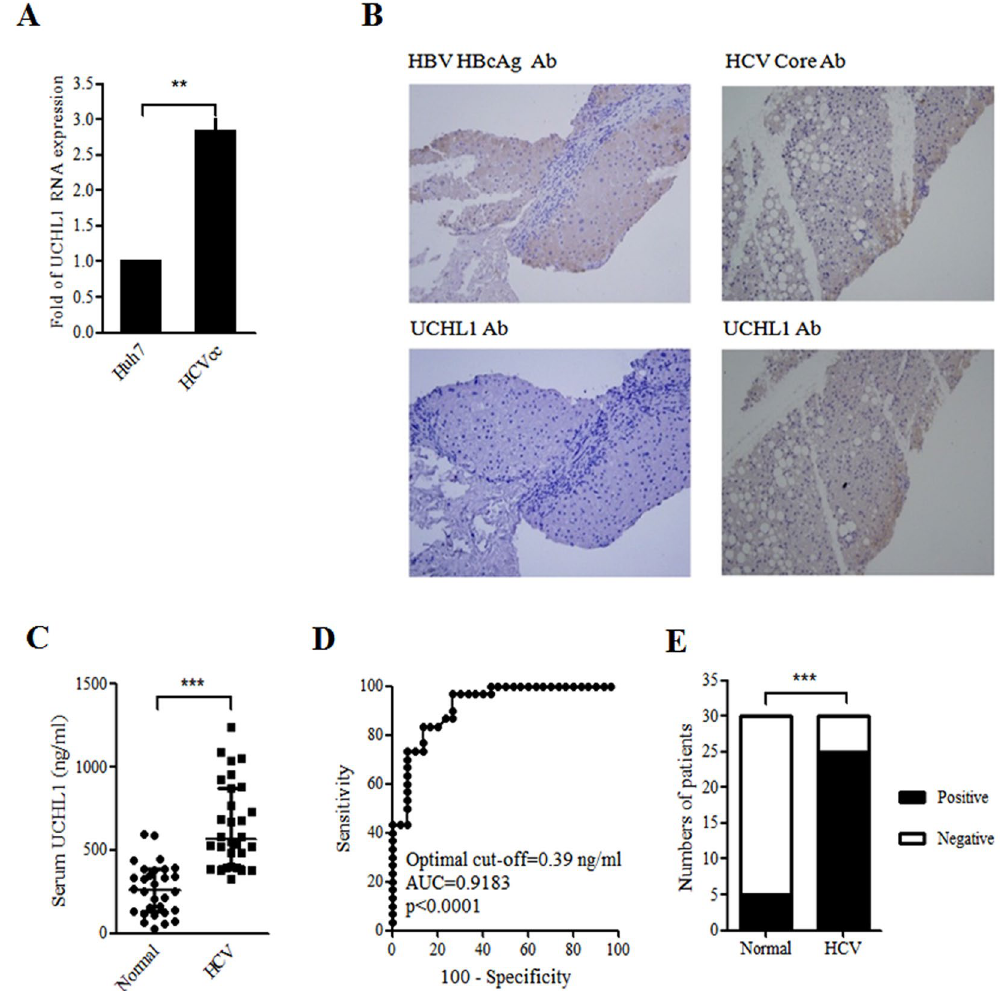
Figure 4. HCV induced UCHL1 expression in Huh7 cells and in the liver section and plasma of hepatitis C patients. ( A ) Huh7 cells were infected with HCVcc (JFH1, MOI 1) for 4 h and cultured for an additional 72 h after removing HCV infectious particles by washing three times with DMEM followed by suspension of the Huh7 cells in DMEM supplemented with 2% FBS. The cellular RNAs were collected for real-time RT-PCR analysis of UCHL1 mRNA expression. The data represent the mean ± S.D. of 3 independent experiments. ** p < 0.01. ( B ) Liver biopsies from patients with CHC (right panel) and CBC (left panel) were subject to immunohistochemical staining of the indicated viral markers (upper panel) and UCHL1 (lower panel), respectively. Representative data are shown. The original magnification was 200X. ( C ) The expression levels of UCHL1 in the plasma of the healthy control and the patients with CHC were analyzed by ELSA assay. The plasma level of UCHL1 for each individual was shown in the scatter dot plot. The medium and the interquartile range for each group are indicated by the horizontal lines. *** p < 0.001. ( D ) ROC curve analysis was used to predict the clinical significance for the expression of plasma UCHL1. For the best compromise sensitivity/ specificity, the area under the ROC curve was 0.9183 (95% CI: 0.8508 to 0.9859, p < 0.0001) with a sensitivity of 83.3% and a specificity of 86.7% for a cut-off value of 0.39 ng/ml. AUC, area under the curve; CI, confidence interval. ( E ) The individuals with plasma UCHL1 greater than 0.39 ng/ml were considered as positive for the UCHL1 test. The number for the healthy control and the patients with CHC who were positive and negative for the UCHL1 test are shown (n = 30). *** p <